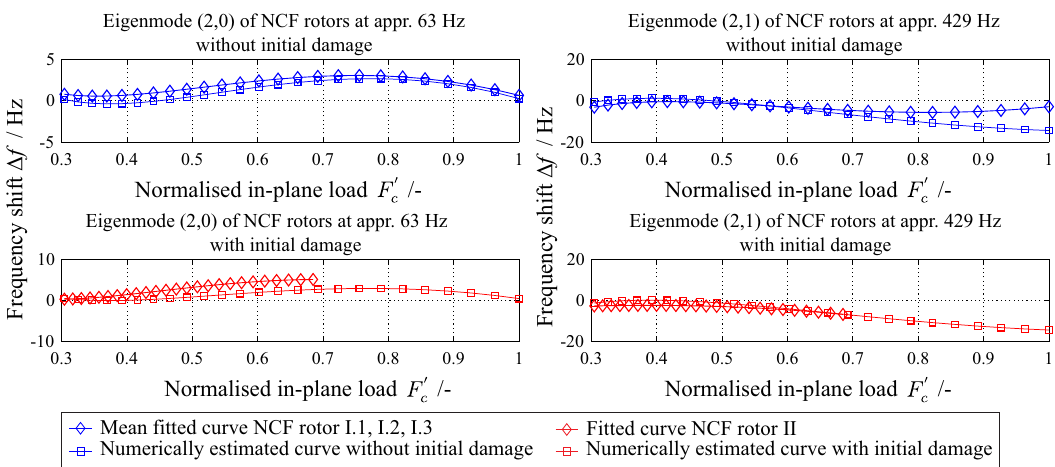
Figure 14. Experimentally and numerically determined change of the eigenfrequency for two eigenmodes of a rotor, with and without initial damage.